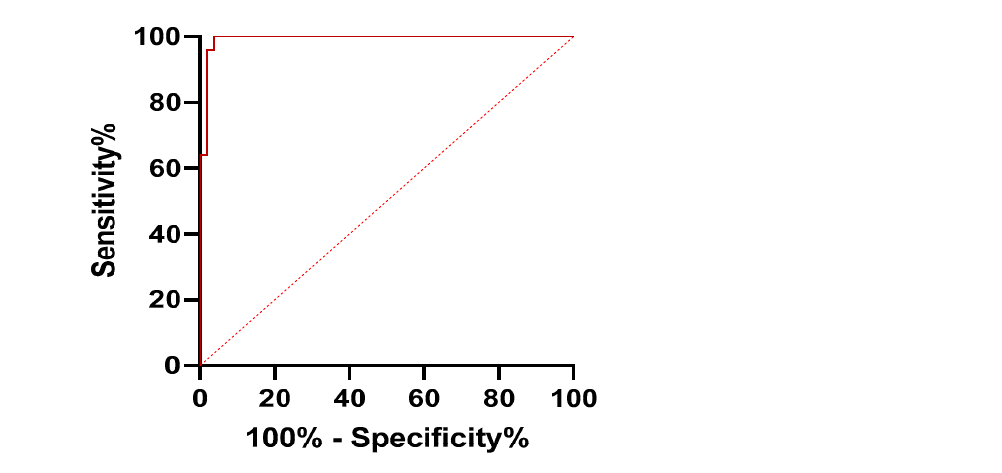
Figure 6. Receiver operator characteristics (ROCs) curve of mean SR values for differential diagnosis of adenomyosis from uterine fibroids.